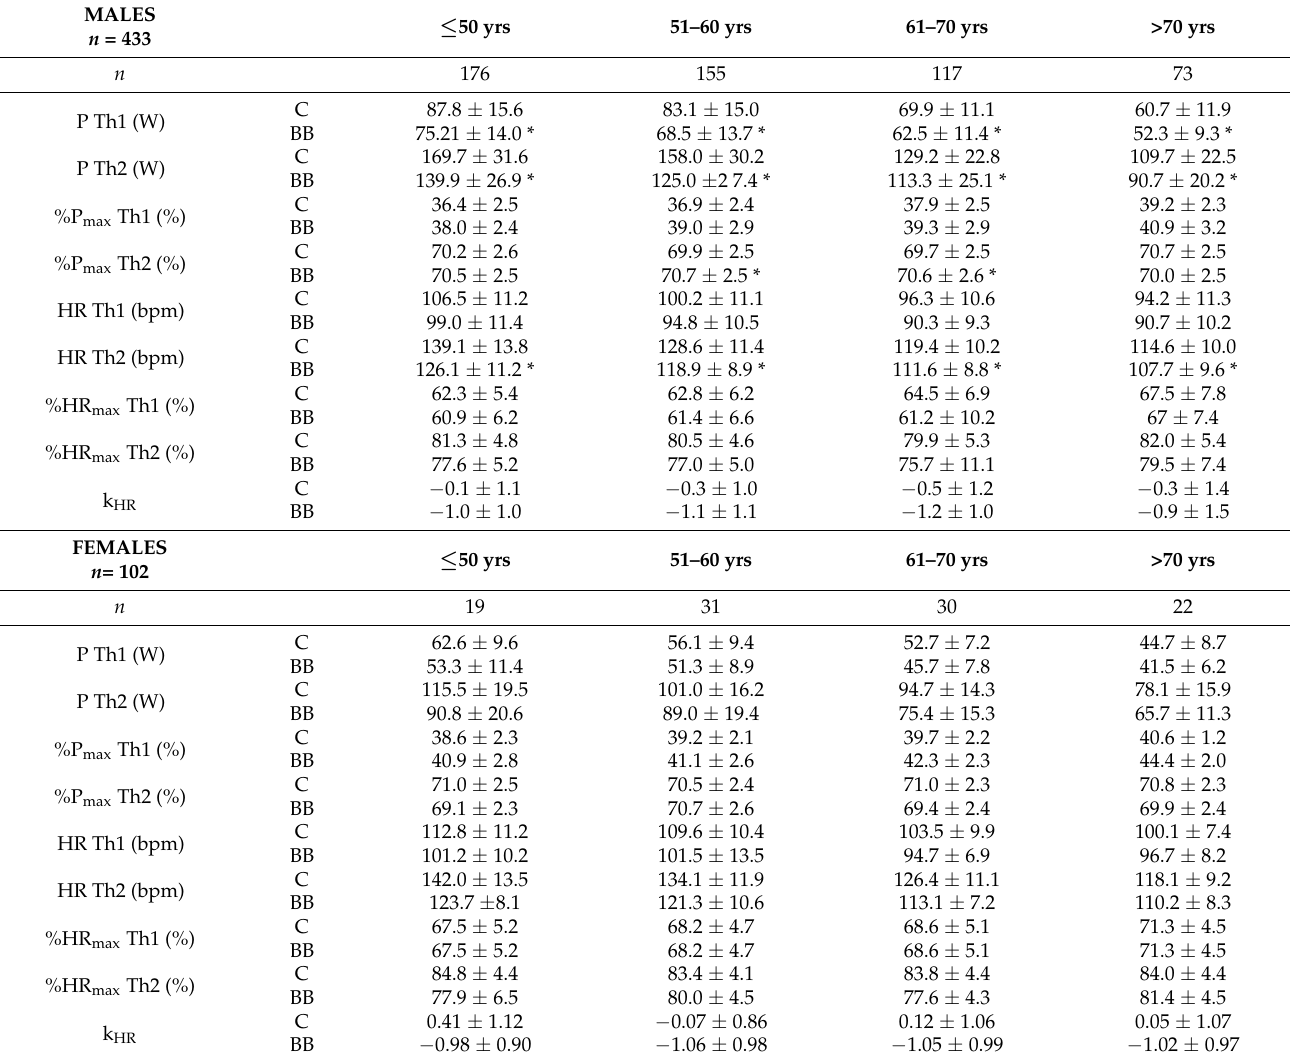
Table 2. Characteristics of the incremental cycle ergometer test in male and female individuals with (BB) and without (C) β -blocker treatment in four representative age groups shown as mean ( ±